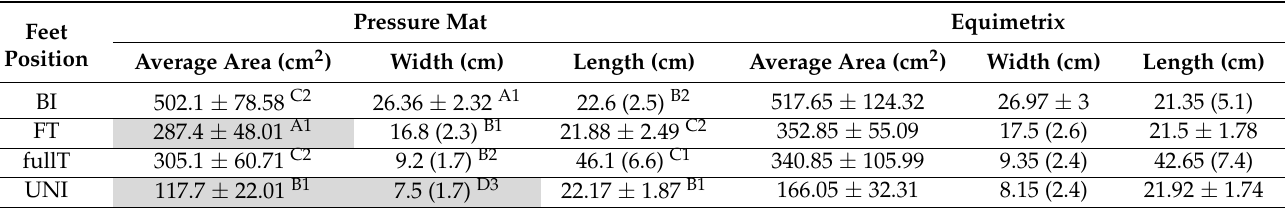
Table 8. Descriptive and reliability statistical results of the base of support parameters between the Equimetrix device and the pressure mat. Parametric data is expressed as Mean ± Standard-deviation, while non-parametric data is express as Median (Inter-quartile